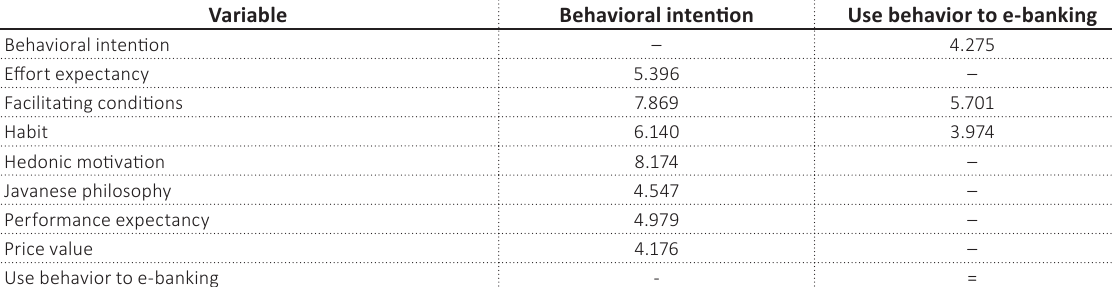
Table 4. Collinearity statistics (VIF)